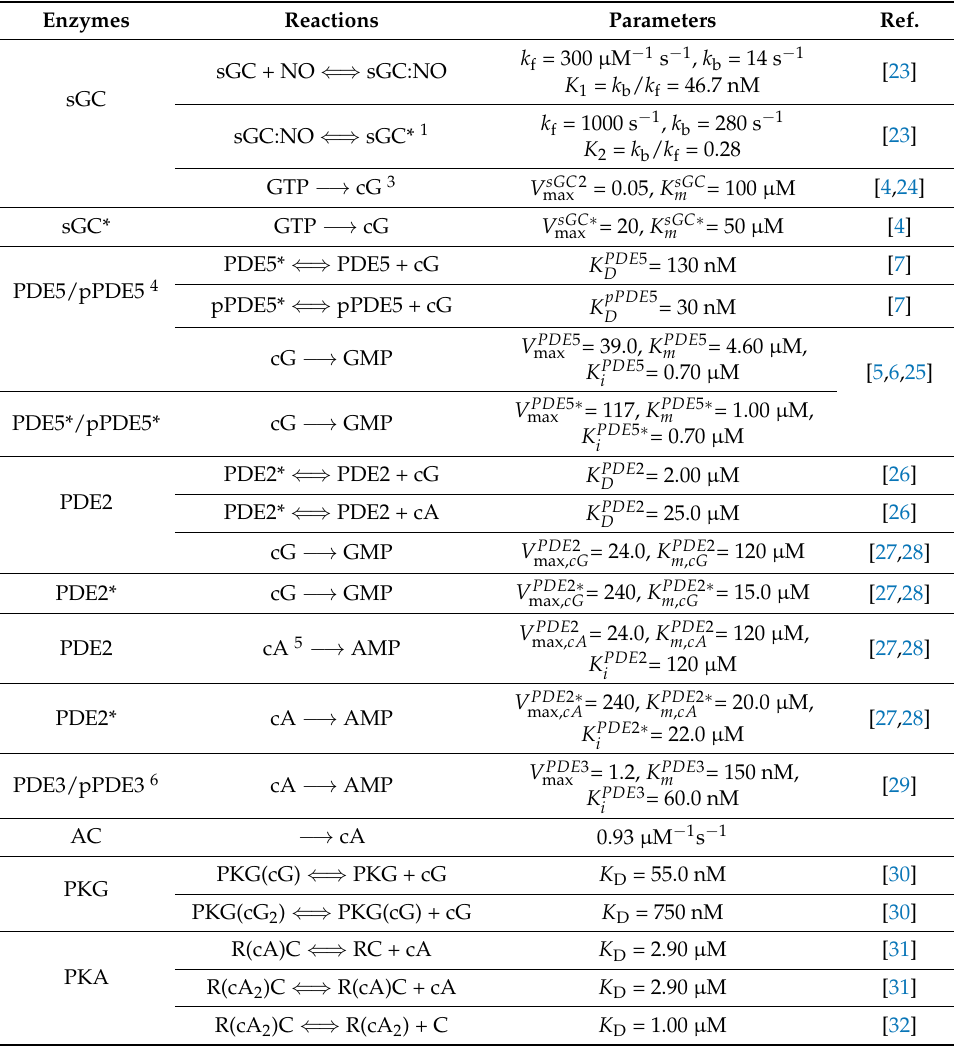
Table 1. Description of model parameters. The kinetic parameters used in the different models are shown below. For the two compartment models, the V max values were varied as described in the figures. For models where PDE phosphorylation was incorporated ([PDE5] tot 1.0 µ M, [PDE3] tot 1.2 µ M), the V max values were refitted to experimental cNMP values. [GTP] fixed at 600 µ